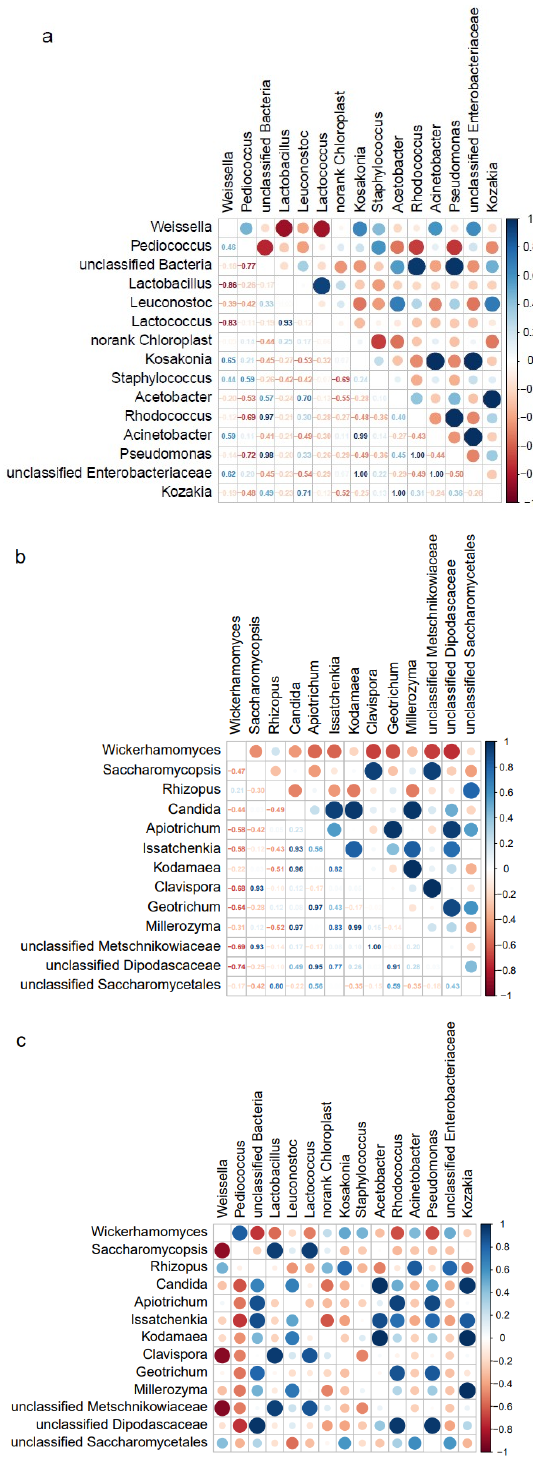
Figure 4. Correlation matrix of Spearman rank correlation between the dominant microbial genera. Spearman’s rank correlation coefficient is between 1.0 and − 1.0, indicating a range from strong positive to strong negative correlations. Circle size indicates the strength of correlation; the large circle is a strong correlation, and the small circle is a weak correlation. The color of the scale bar indicates the nature of the correlation, with blue indicating a positive correlation and red indicating a negative correlation. ( a ) Spearman rank correlation matrices are shown for bacteria with >1% abundance; ( b ) Spearman rank correlation matrices are shown for fungal species with >1% abundance; ( c ) Spearman rank correlation matrices are shown for bacterial/fungal species with >1% abundance.